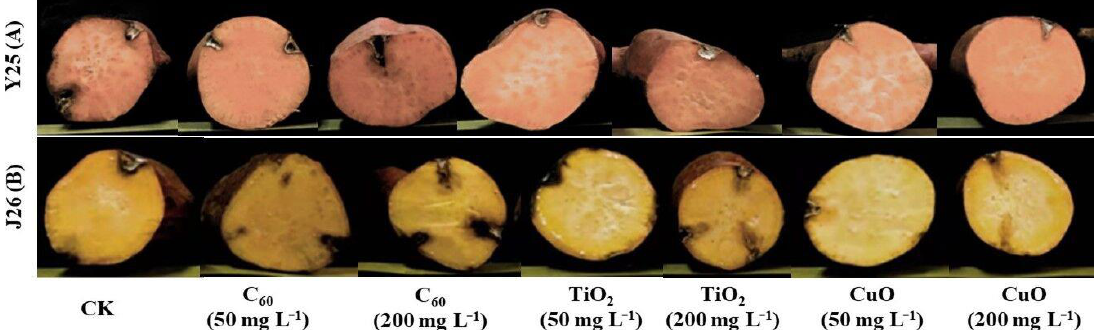
Figure 2. Representative images of the cross sections of sweet potatoes inoculated against soft rot: ( A ) representing Y25 cultivar and ( B ) representing J26 cultivar of sweet potato at different concentrations of NMs. CK is not sprayed with any NMs.